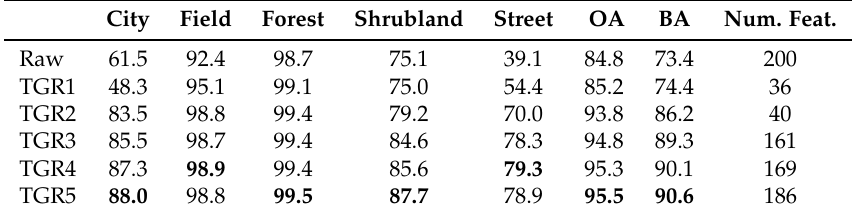
Table 4. Summary of the classification results (in percent) for tomogram features. Best accuracies are indicated in bold